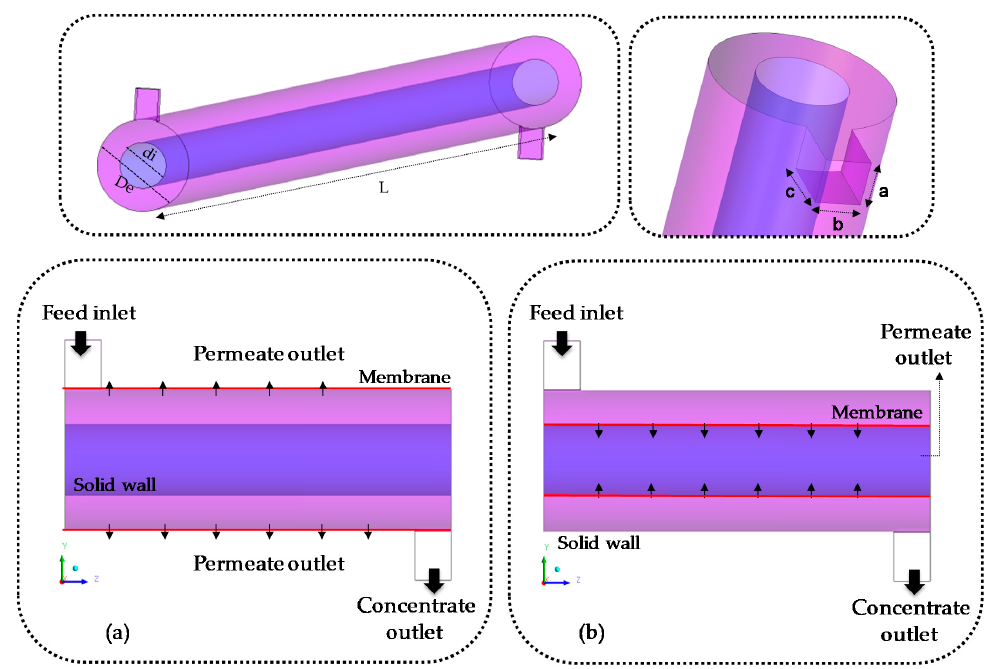
Figure 3. Geometric representation of the 3D separation module: ( a ) membrane in the external tube; ( b ) membrane in the internal tube.